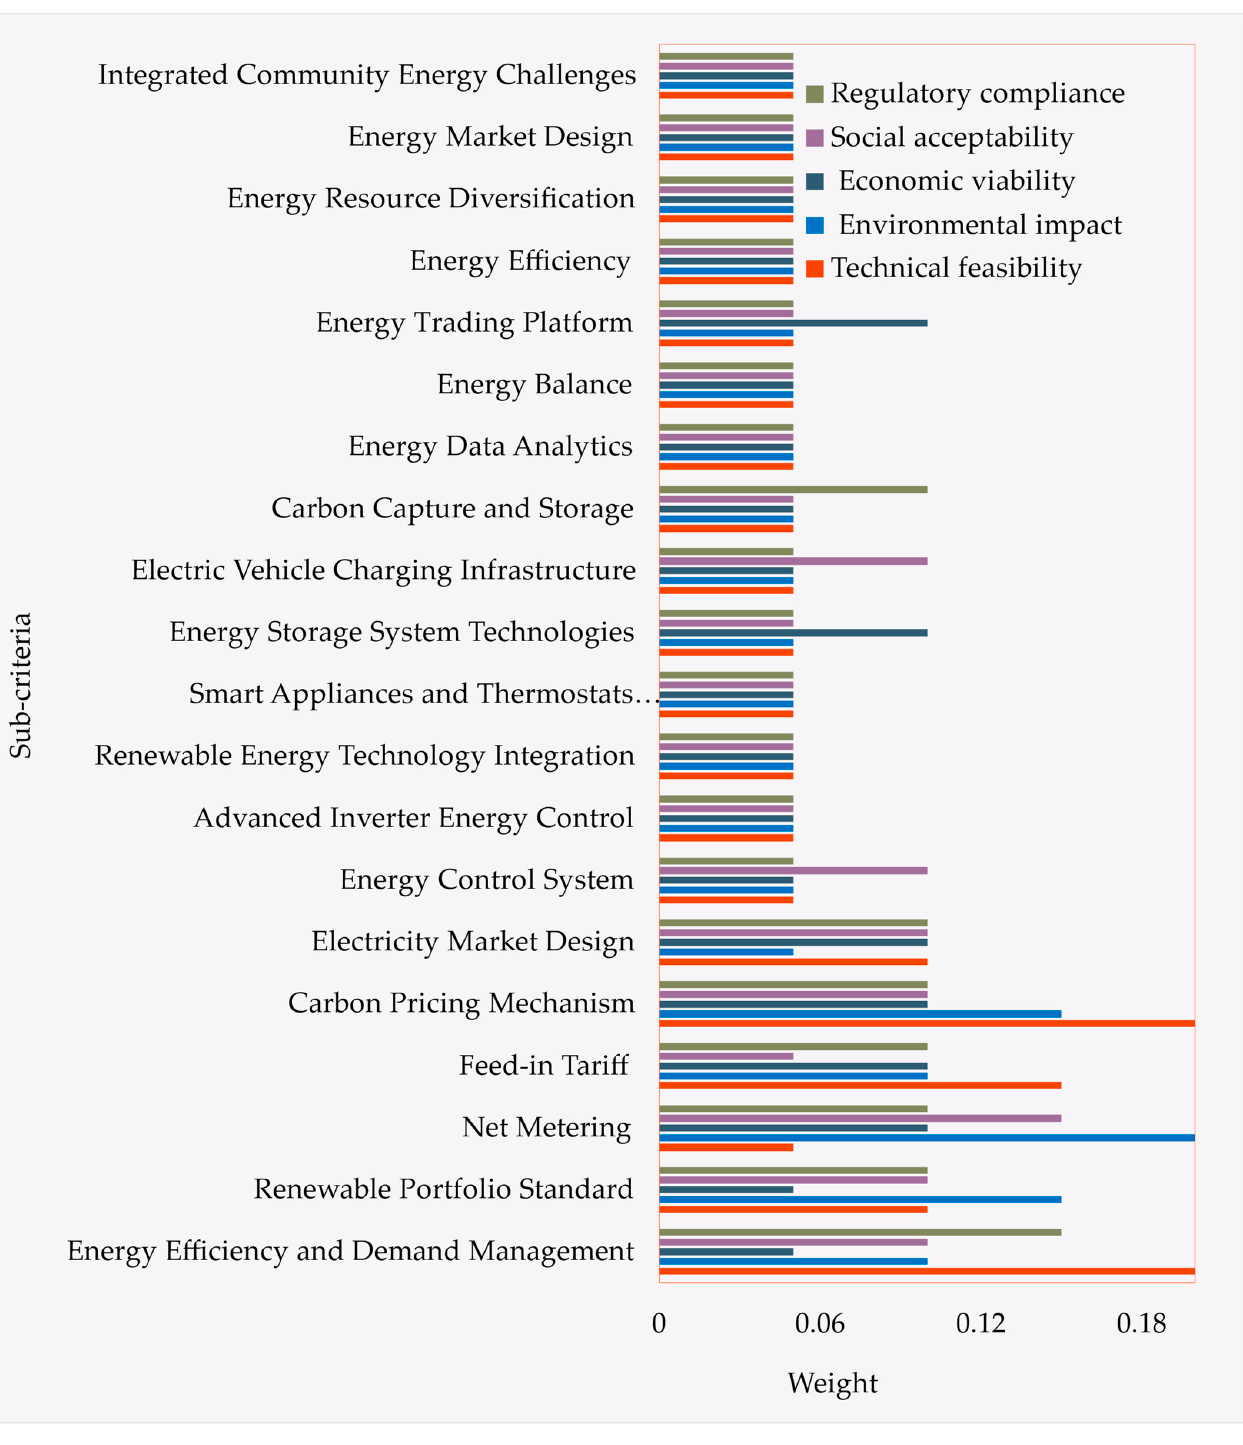
Figure 8. Criteria (equal importance assigned to all five criteria) and sub-criteria weights (varying importance assigned to sub-criteria within each criterion).